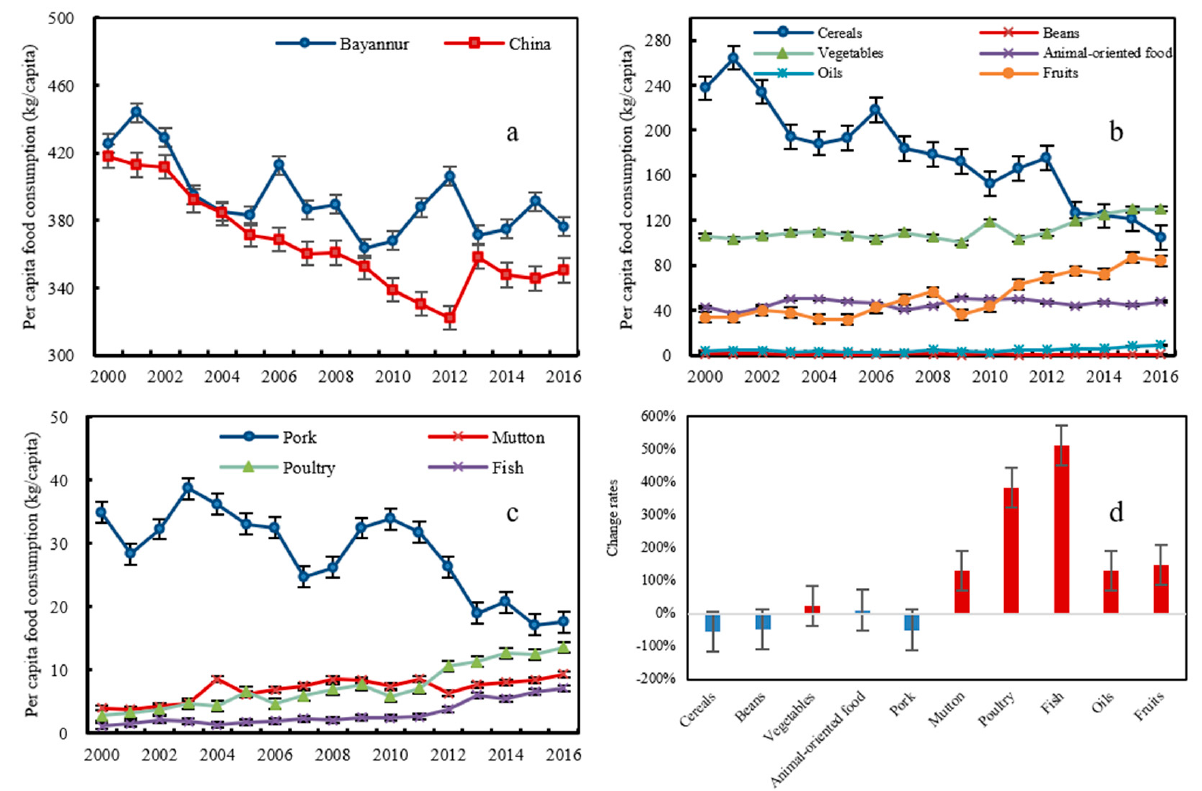
Figure 3. Changes in the per capita food consumption in Bayannur from 2000–2016: ( a ) per-capita food consumption in Bayannur and China; ( b ) per-capita consumption of all individual food items in Bayannur; ( c ) per-capita animal-oriented food consumption in Bayannur; and ( d ) changes in the consumption of all food items.